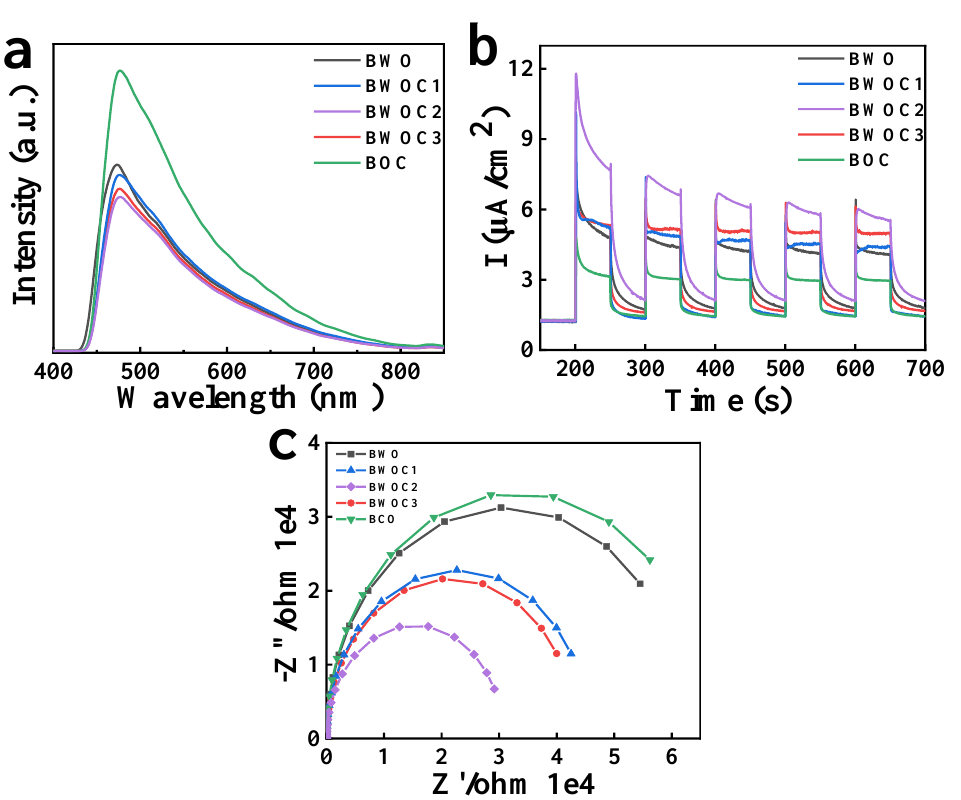
Figure 6. ( a ) PL, ( b ) I-t curve, and ( c ) electrochemical impedance spectroscopy of the as-prepared samples.